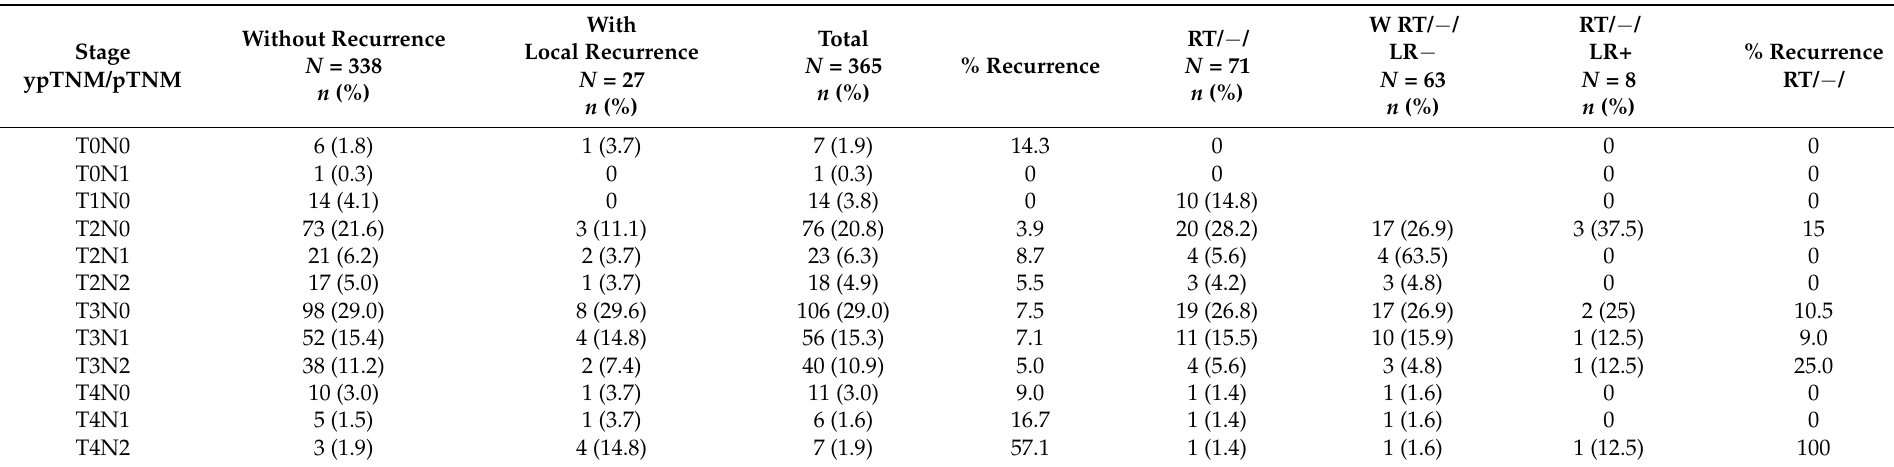
Table 3. Frequency rate of recurrence for patients with rectal cancer according to ypTNM /pTNM staging and without perioperative